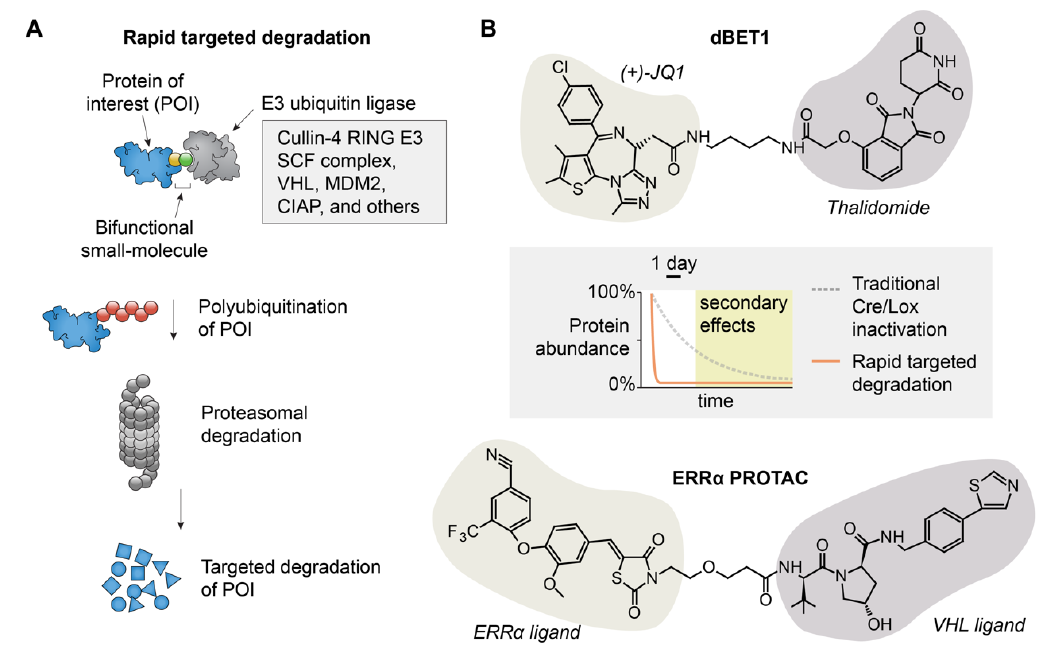
Figure 3. Rapid targeted protein degradation with heterobifunctional small molecules. ( A ) Proteins of interest are linked to E3 ubiquitin ligases. The ensuing polyubiquitination induces rapid proteasomal degradation; ( B ) Example heterobifunctional PROTAC small molecules and comparison of the kinetics of targeted degradation relative to traditional Cre/Lox inactivation.